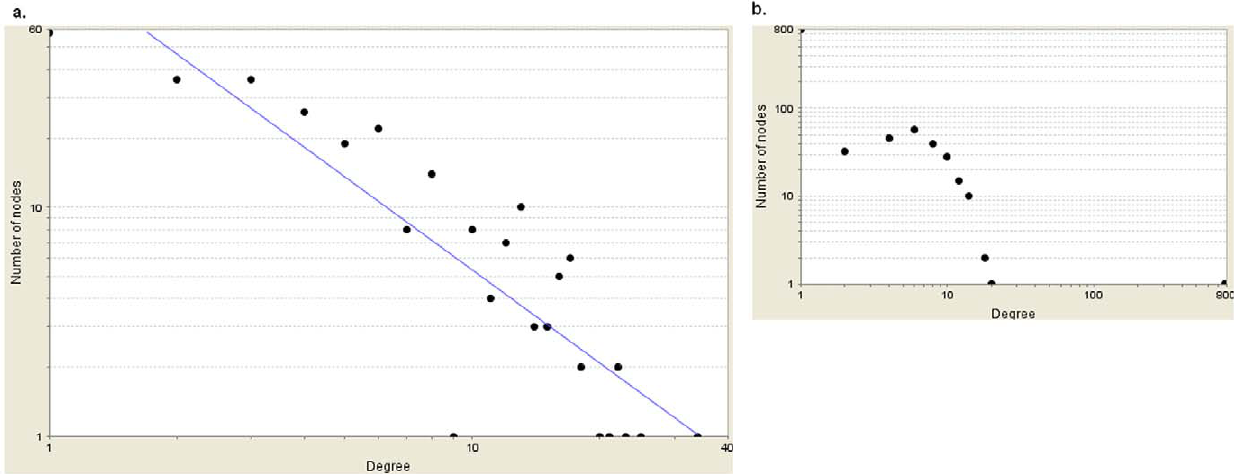
Figure 3. Node degree distributions of our highest scoring sub-network vs. random network. a. Our sub-network follows a power-law (P(k)=ax 2 c , a=120.03, c =1.353, R 2 =0.773, Correlation=0.891 in log log scale), showing that our network displays scale-free properties, as expected from a biological network. b. The random network is obtained via randomization of our highest scoring sub-network using Erdos-Renyi algorithm.